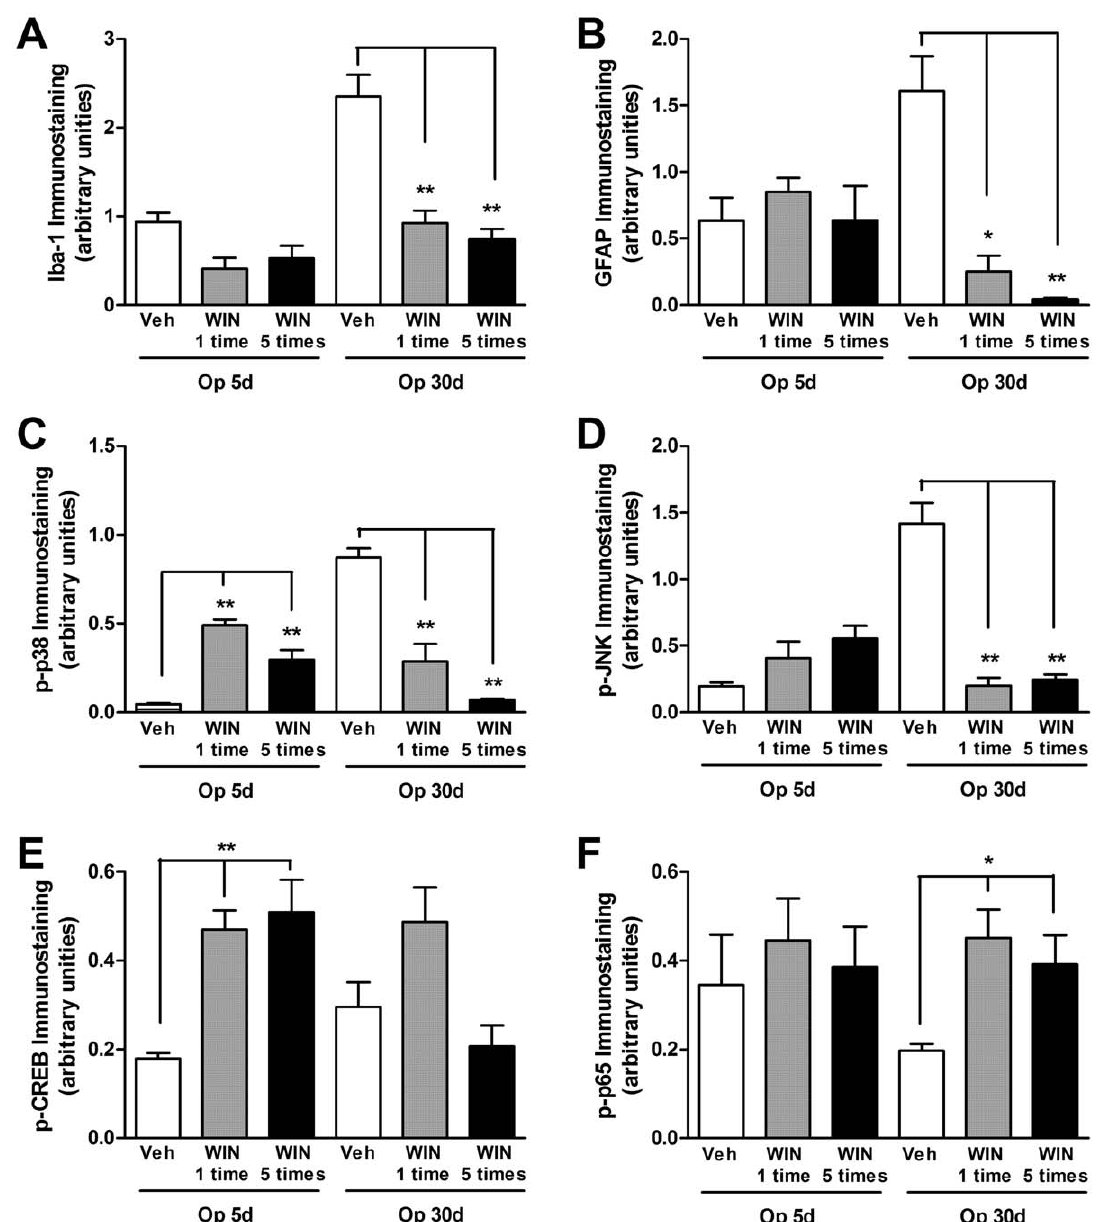
Figure 10. Effect of cannabinoid agonist on the expression of glial cells, MAP kinases and transcription factors in the dorsal horn of the spinal cord after brachial plexus avulsion (BPA) in mice. Effects of acute (once) or long-term (five times, 12 6 12 h) treatment with WIN 55,212-2 (3 mg/kg, i.p.) on the 5 th or 30 th days after BPA on the expression of activated microglia (Iba-1, A), astrocytes (GFAP, B), phospho-p38 (p-p38, C), phospho-JNK (p-JNK, D), phospho-CREB (p-CREB, E) and phospho-p65 NF- k B (p-p65, F). Immunostaining intensity and area were quantified by image analysis and are expressed as arbitrary units (mean 6 SEM, n=4/slices of 4–6/groups). *p , 0.05 and **p , 0.01, compared with sham-operated of respective group and time (one-way ANOVA followed by Bonferroni’s post hoc test). JNK: c-Jun N-terminal kinase; CREB: cAMP response element- binding protein; p65 NF- k B: nuclear phospho-p65 nuclear factor- k B (NF- k B).